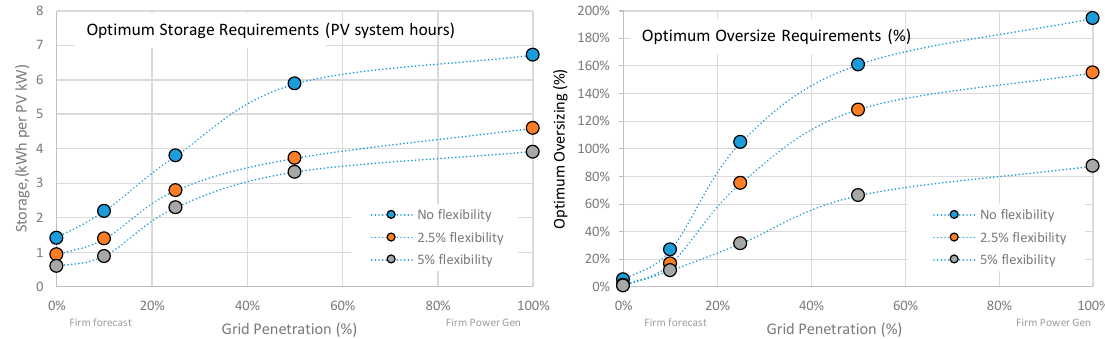
Figure 7. Physical storage ( left ) and implicit storage ( right ) optimum requirements as a function of penetration and flexibility. These illustrative plots are for the entire NYISO and represent a mean of current and future cost scenarios. Note the mentions of “firm forecast” at low penetration and “firm power generation” at high penetration indicating the morphing of load shape requirements from [current] low penetration where PV operates at the margin to grid-dominant PV where firm power generation will be a requirement.